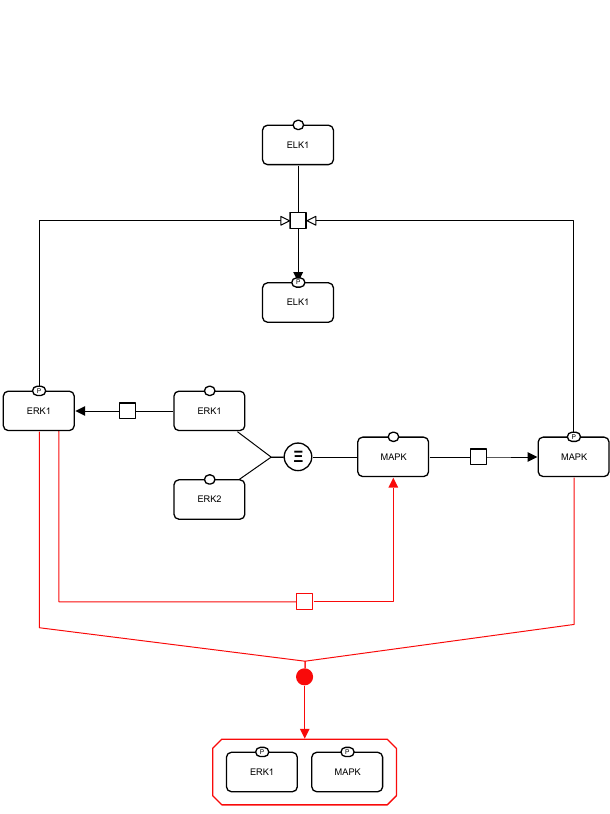
Figure B.4: An example of misuse of the equivalence operator in a signalling pathway. Be- cause the phosphorylation of ERK1 is ‘included” in the phosphorylation of MAPK, phospho- rylated ERK1 and phosphorylated MAPK are overlapping pools, which contradicts the first rule. As for the two processes marked in red, they both contradict the second rule, because phosphorylated ERK1 is on one side of the equivalence operator , while MAPK and phos- phorylated MAPK are on its other side. In terms of automatic verification, phosphorylation of MAPK can be split into two processes: phosphorylation of ERK1 and phosphorylation of ERK2 since MAPK is equivalent to ERK1 and ERK2; then there would be a repeating process of ERK1